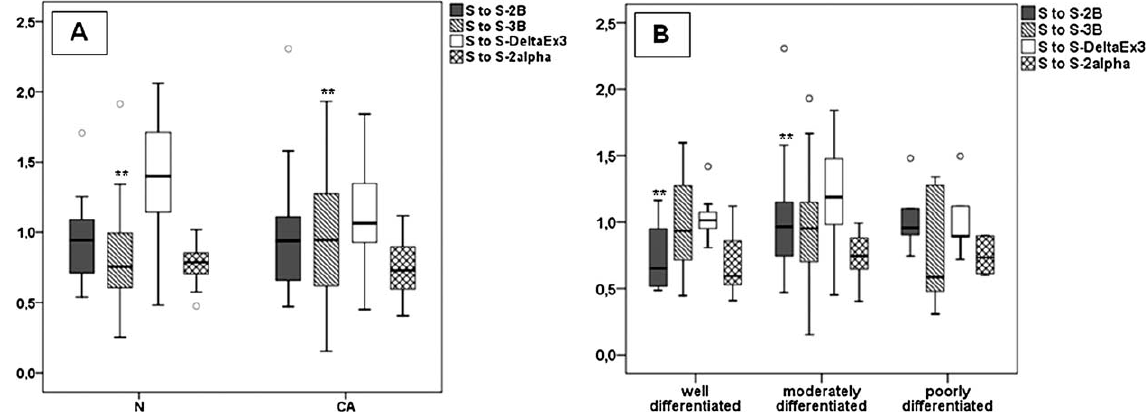
Fig. 3. The change of ratios of expression of the different variants in normal and neoplastic tissue and according to degree of differentiation. ** indicate differences significant to the 0.05 level. heterozygotes (odds ratio 1.587, 95% CI: 0.997–2.526, p = 0 .